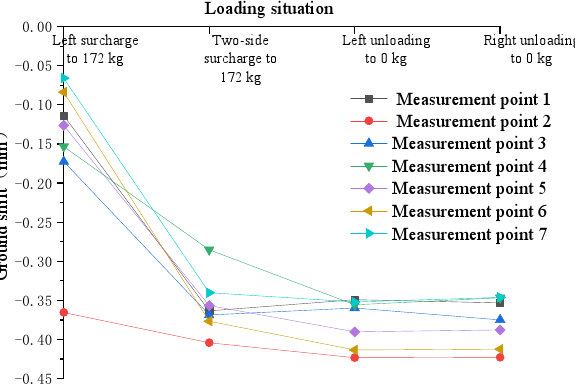
Figure 20. Variation in ground shift at each measurement point under different surcharges for Case 4.